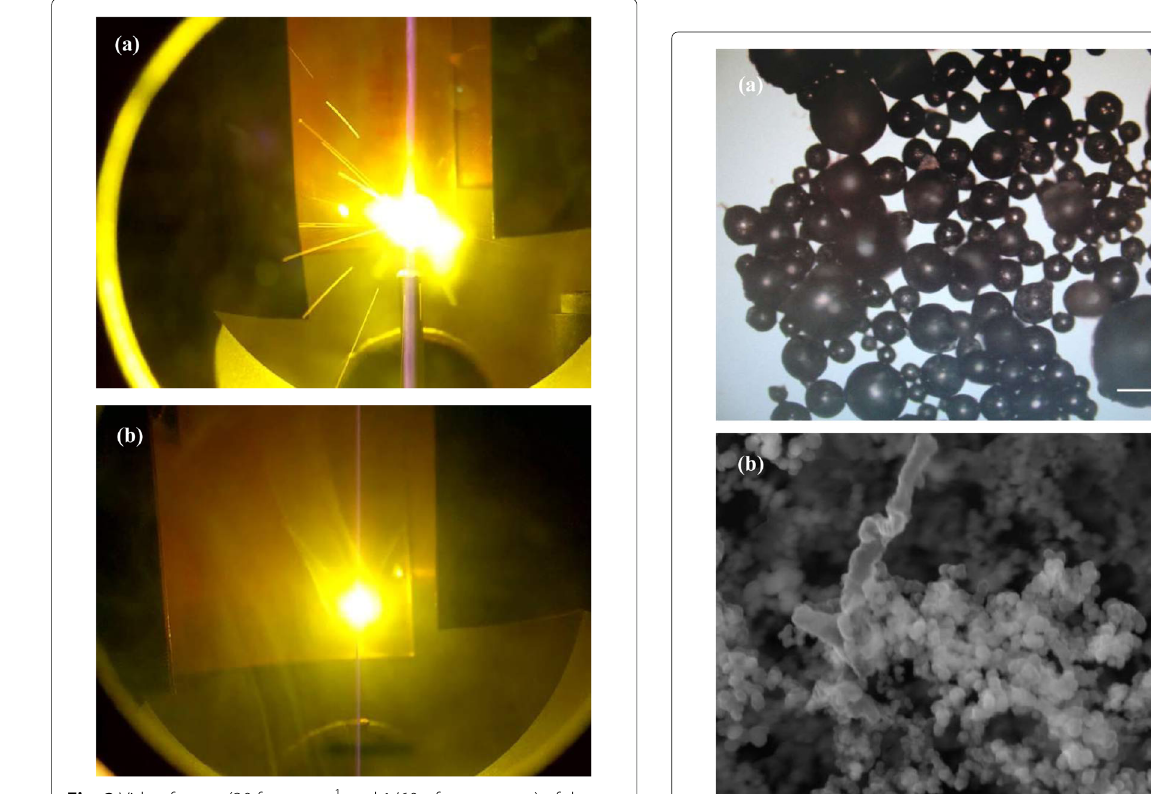
Size-frequency distribution of silicate droplets